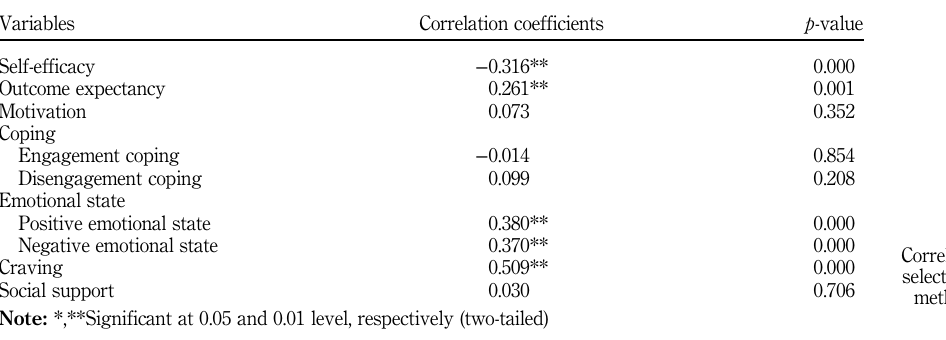
selected factors and